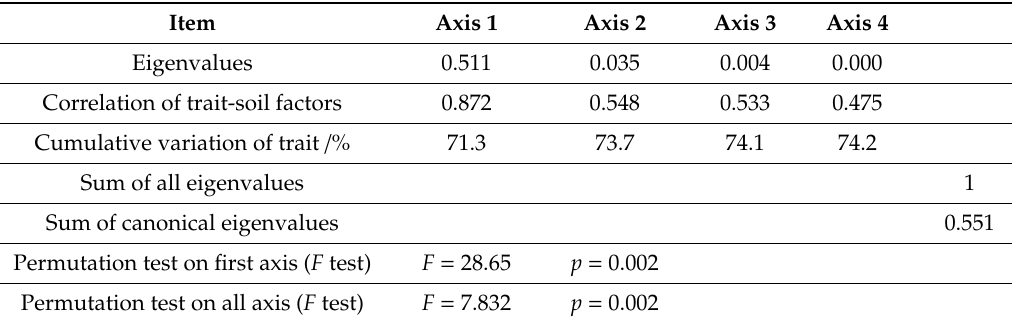
Table 6. RDA ranking of trait and soil chemical property of E. urophylla × E.